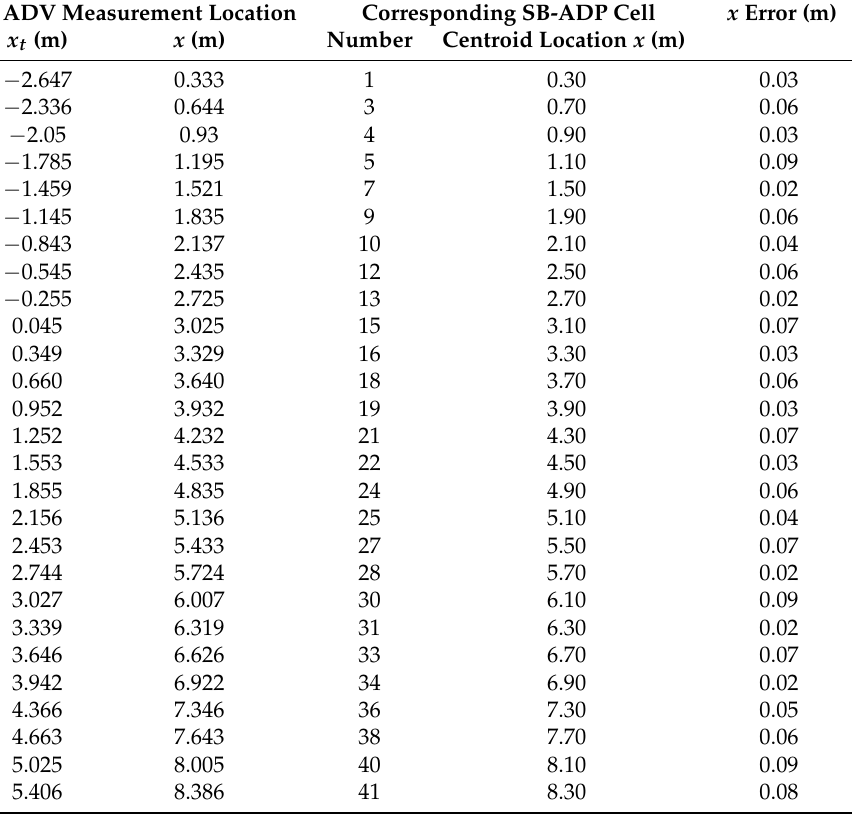
Table 3. Measurement locations at which inter-instrument comparison was performed for a nominal tank velocity of 0.8 ms − 1 . ADV measurements locations from [8,29] are reported with reference of the tank centre ( x t ) and to the SB-ADP ( x ). The SB-ADP co-located measurement cell numbers and their centre position along the x -axis are displayed along with the errors along the x -axis between the ADV measurement locations and the corresponding SB-ADP centroid. ADV Measurement Location Corresponding SB-ADP Cell x Error